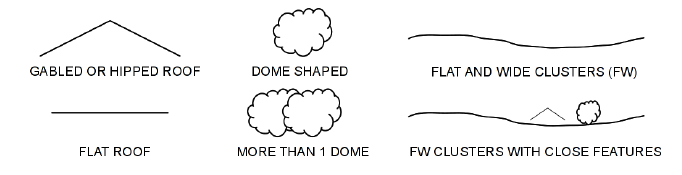
Figure 1: Types of